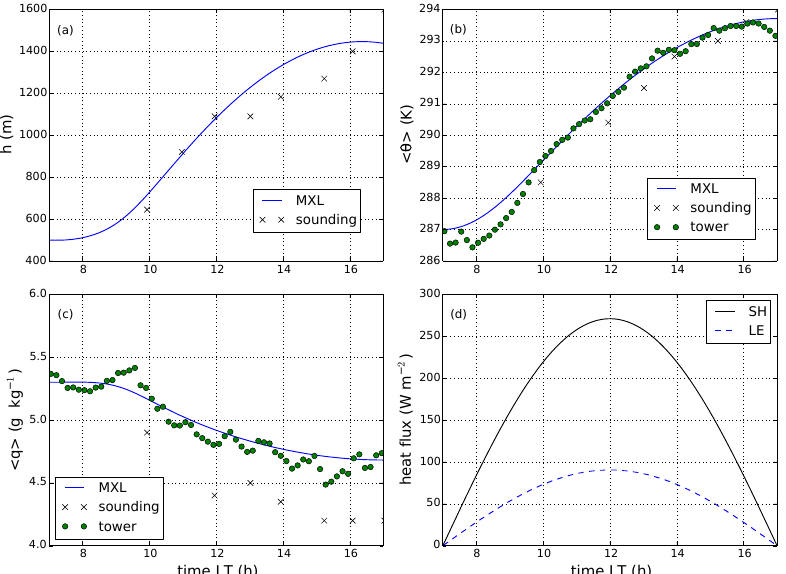
Figure 5. Diurnal evolution of observed and modelled (a) mixed-layer height ( h ), (b) mixed-layer potential temperature ( θ ), (c) mixed-layer specific humidity ( q ) and (d) prescribed sensible (SH) and latent (LE) heat